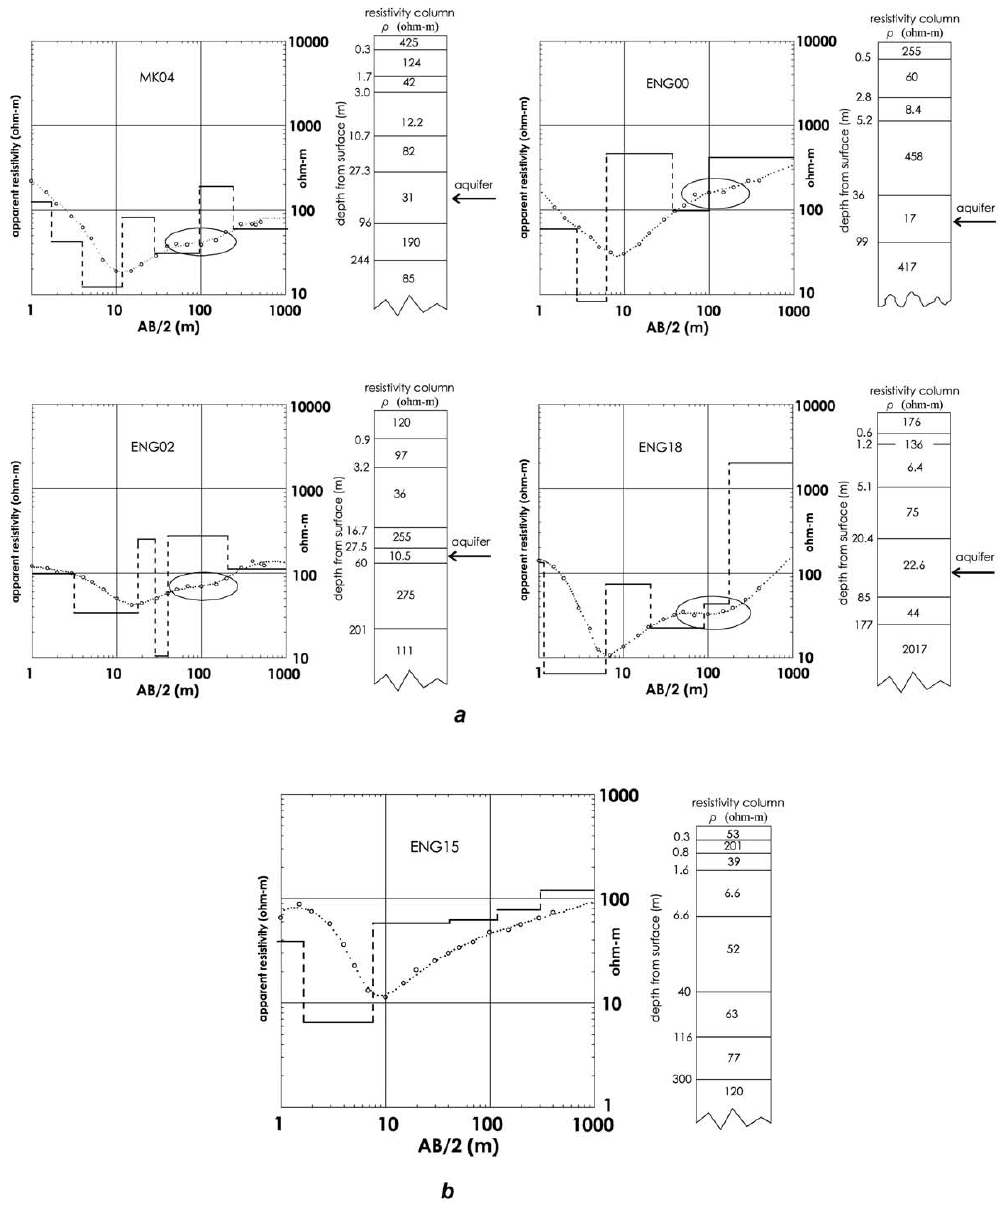
Fig. 5. (a) An apparent resistivity curve (left) and its inferred resistivity column (right). Small circles represent experimental values, and the dotted line the apparent resistivity curve corresponding to the resistivity column on the right. (b) Apparent resistivity curve and interpretation of VES ENG15. The resistivity column suggests that no confined aquifer is